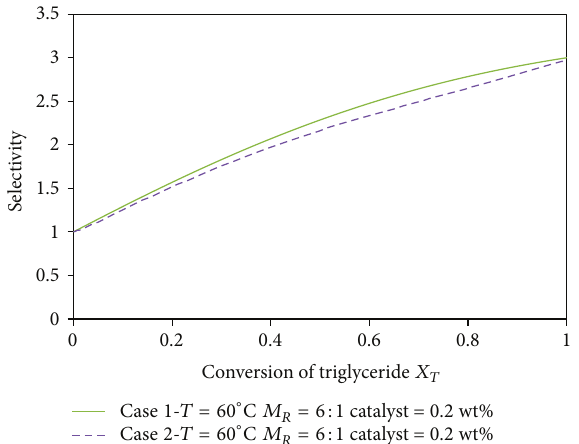
Figure 1: Selectivity plots of Cases 1 and 2 at reaction temperature 60 ∘ C, molar ratio 6: 1, and catalyst concentration 0.2 wt.%.